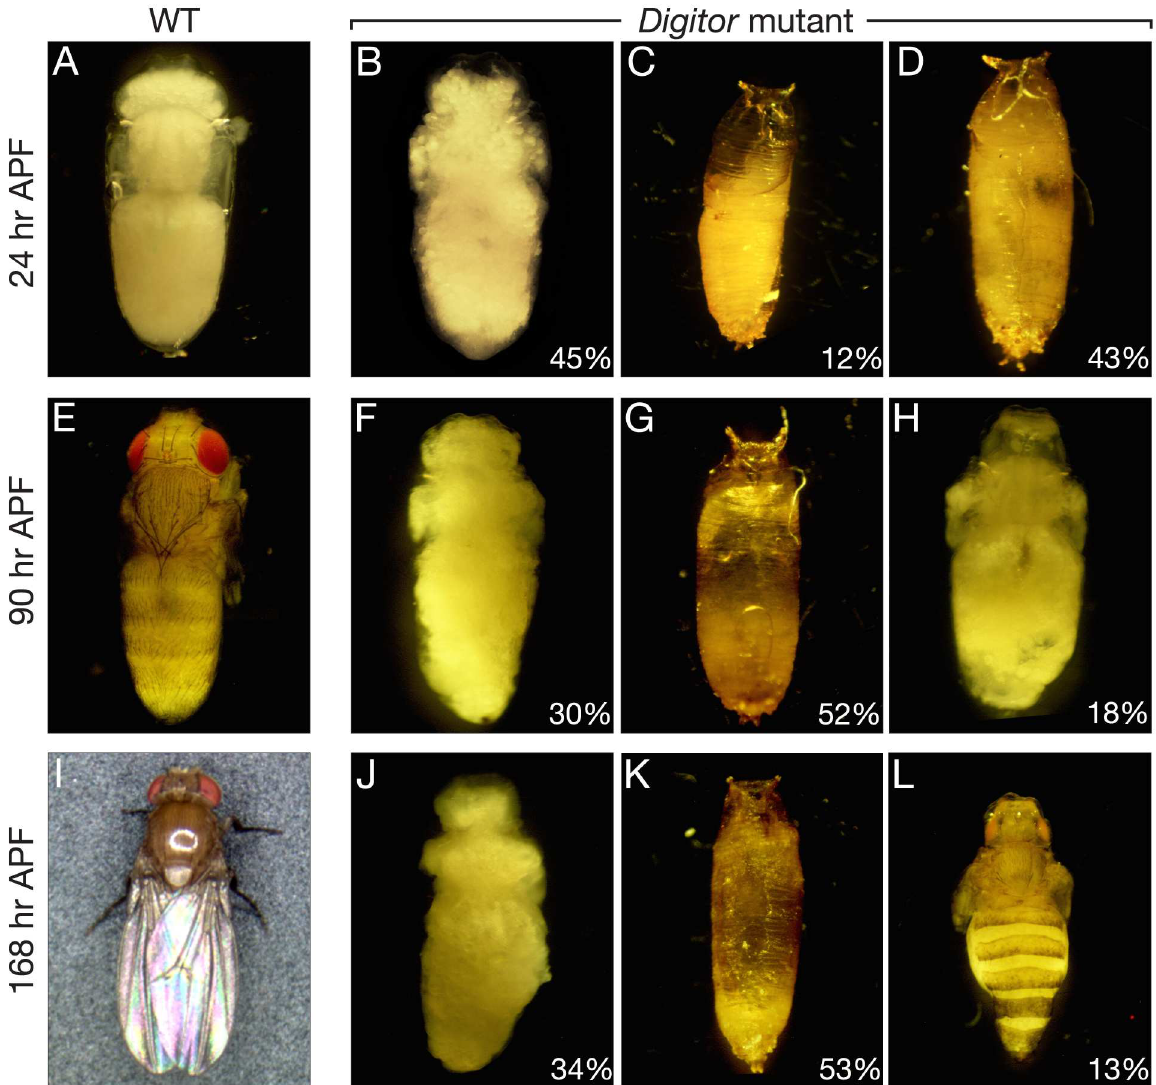
Fig 9. Defective metamorphosis of Digitor mutant pupae. Digitor mutant ( EP(3)3709/EP(3)3709 )and wild type pupae were selectedas white prepupaeand monitored through prepupaland pupal development 24, 90, and 168 hr after pupariumformation (APF). (A) Wild type pupae 24 hr APF. (B-D) Examples of Digitor mutant pupae with impairedand/or defective development at 24 hr APF. (E-H) Wild type and Digitor mutant pupae with impaired or defective metamorphosis at 90 hr APF. (I) At 168 hr APF wild type pupae had eclosedas adult flies. (J-L) Digitor mutant pupaeall failed to eclose at 168 hr APF and were arrested at various stages of pupal development. The frequencyof different types of Digitor mutant pupae is indicatedin percent. In (A), (B), (E), (F), (H), (J), and (L) the pupal case was